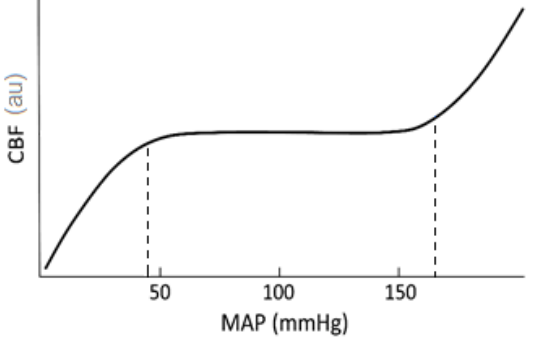
Figure 5. Schematic presentation of the relationship between cerebral blood flow CBF and mean arterial pressure MAP, a ff ected by autoregulation. The autoregulation is only e ff ective between two MAP limits, presented by dashed lines. For MAP lower than the left limit, the brain tissue is ischemic, and for MAP greater than the right limit, the brain tissue is hyperemic, potentially leading to edema with its adverse consequences.